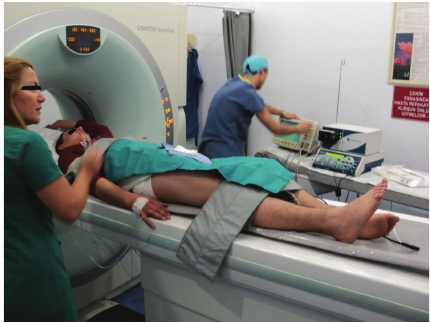
Figure 1: The patient was positioned on CT bed.